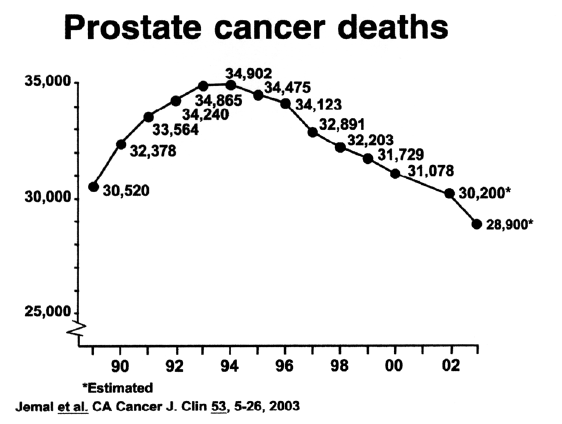
Figure 1 – Prostate cancer deaths in the United States since 1989. Note that deaths have dropped by 17% since